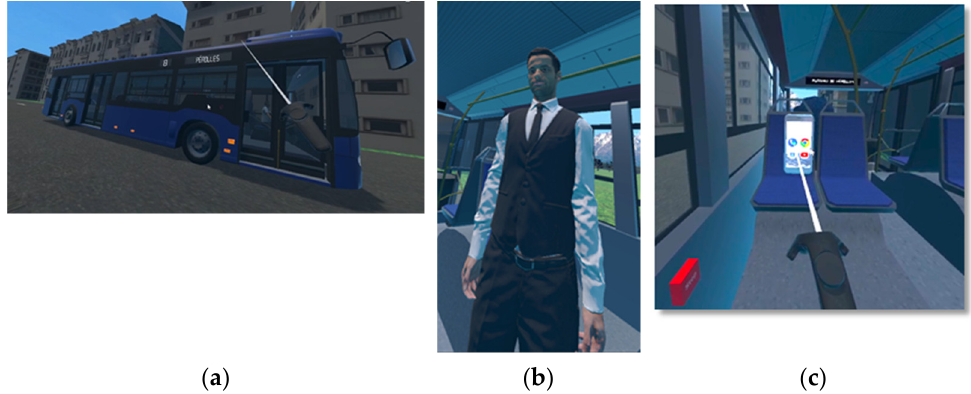
Figure 4. Bus scenario: ( a ) asking for the bus to stop; ( b ) avatar asking to go with him; and ( c ) use of smartphone because of bus breakdown.